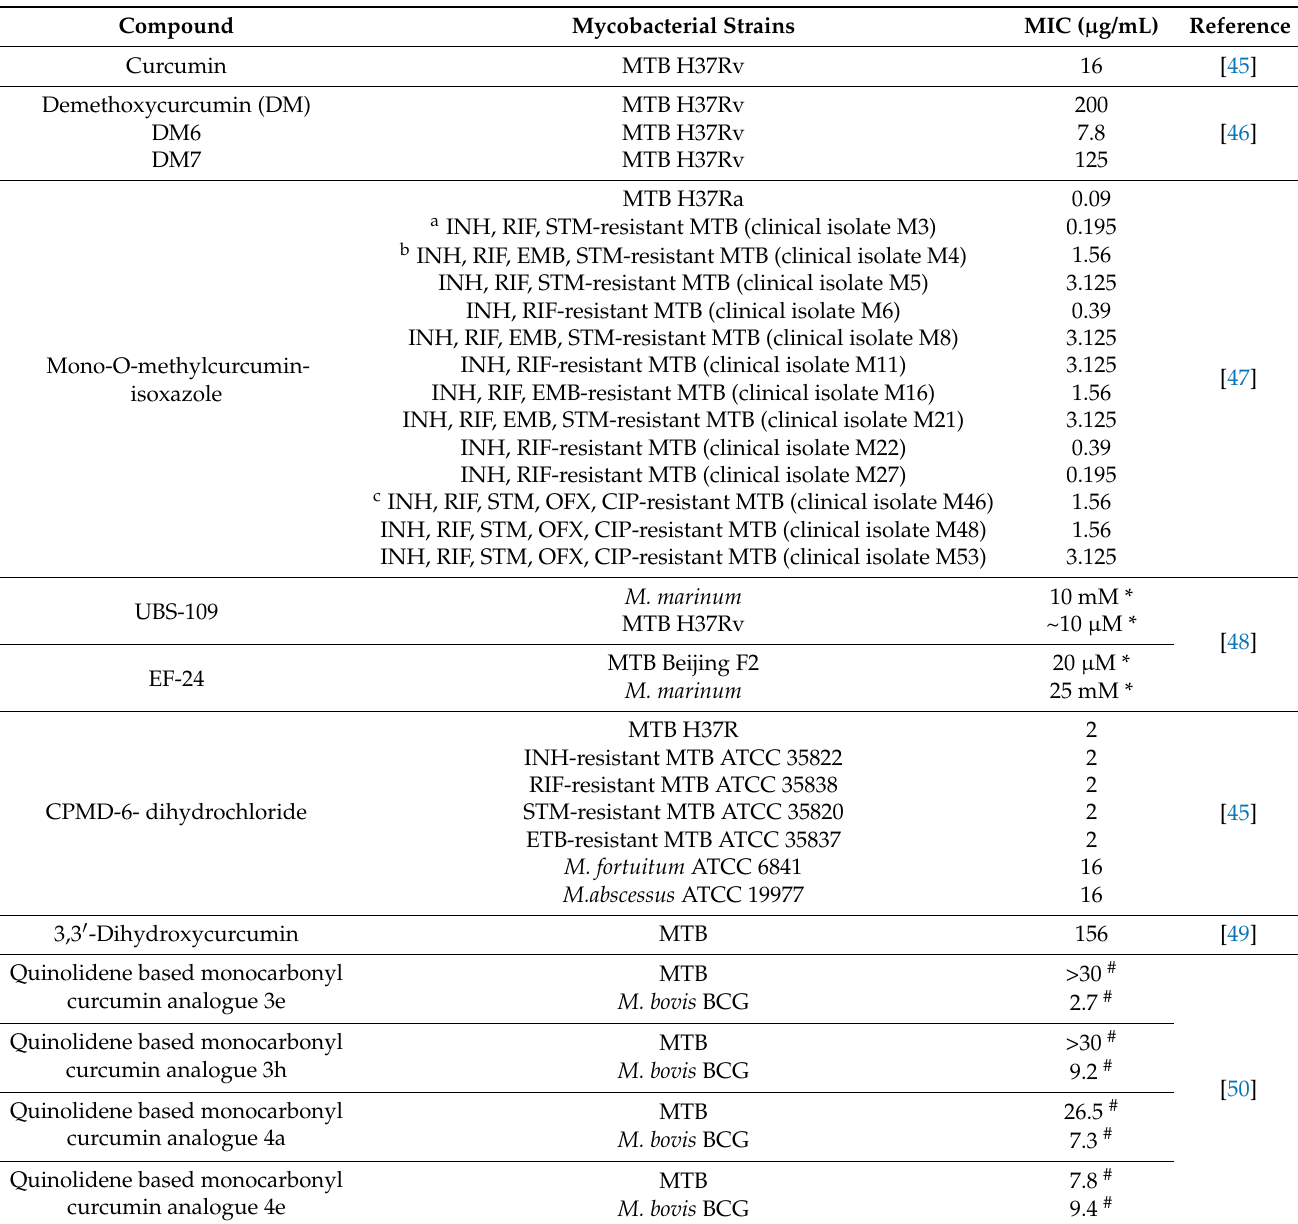
Table 1. Minimum inhibitory concentration of curcumin, demethoxycurcumin, and their respective synthetic analogues against various mycobacterial strains ( µ